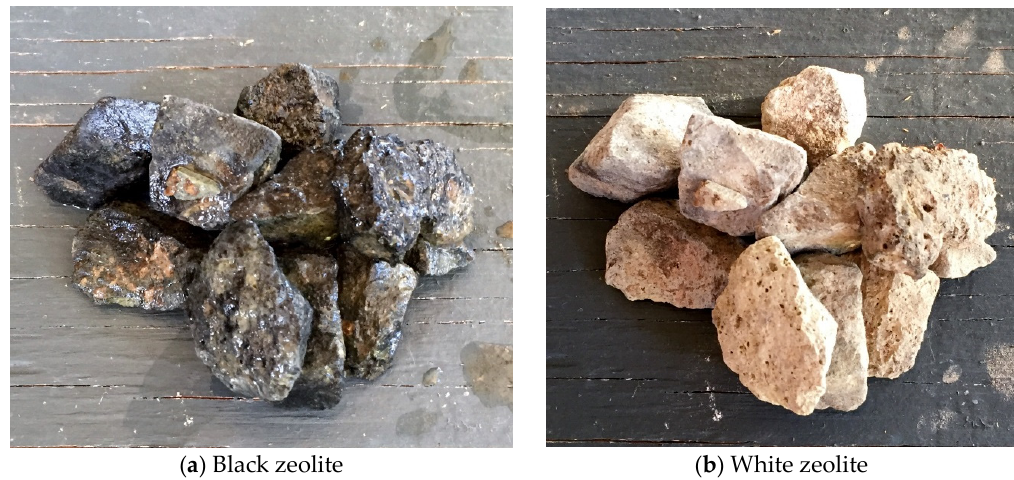
Figure 4. Example photos of zeolite aggregate used in reactors from ( a ) anaerobic layer prior to air- drying with reduced iron coating and ( b ) after air-drying without reduced iron coating.